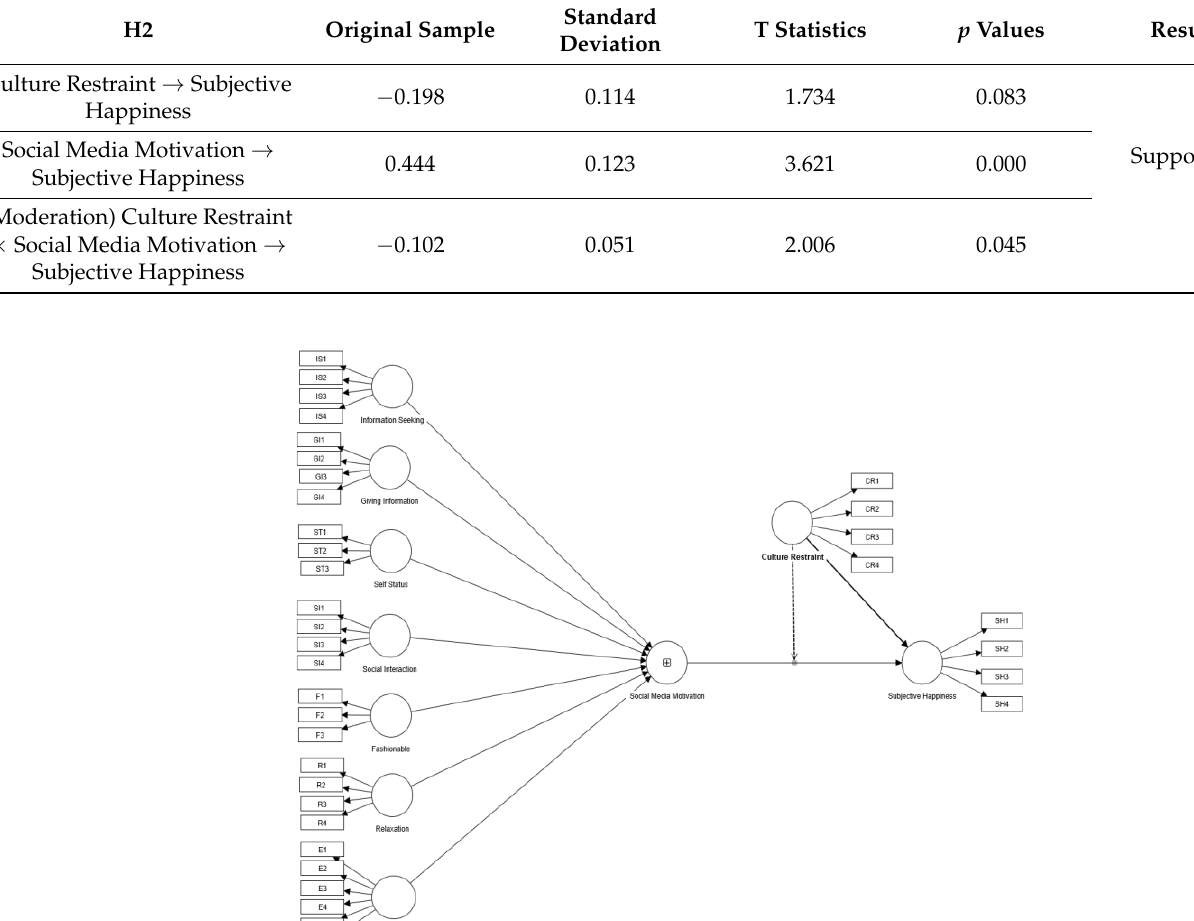
Table 6. The moderation analysis.